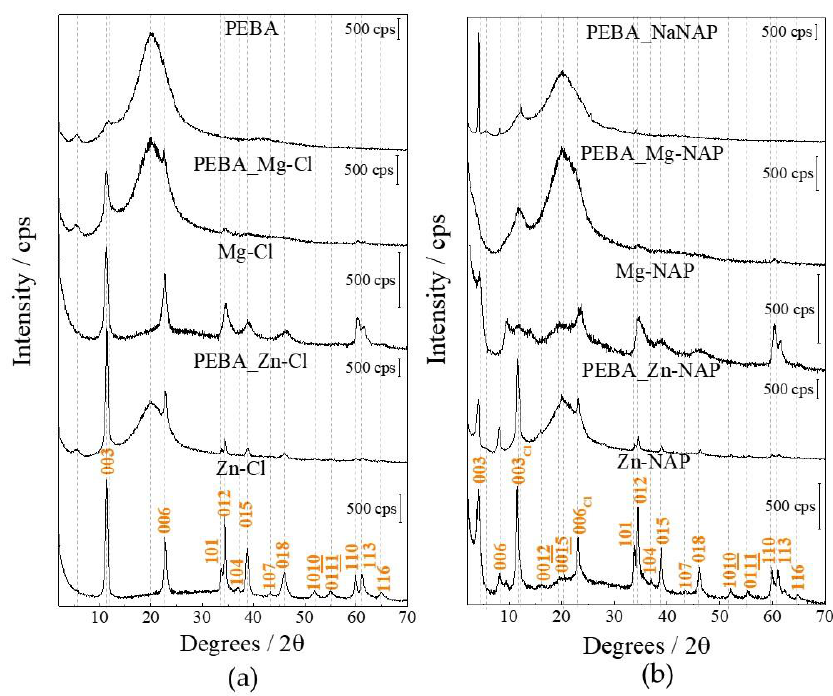
Figure 4. XRD patterns of pristine PEBA and PEBA composites containing Cl-LDHs ( a ) and composites containing the NaNAP salt and NAP-LDHs ( b ).